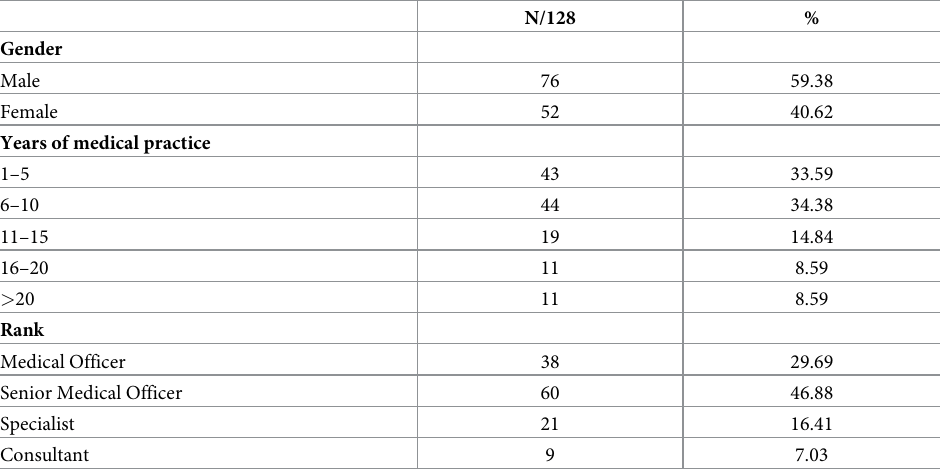
Table 2. Demographics of participant